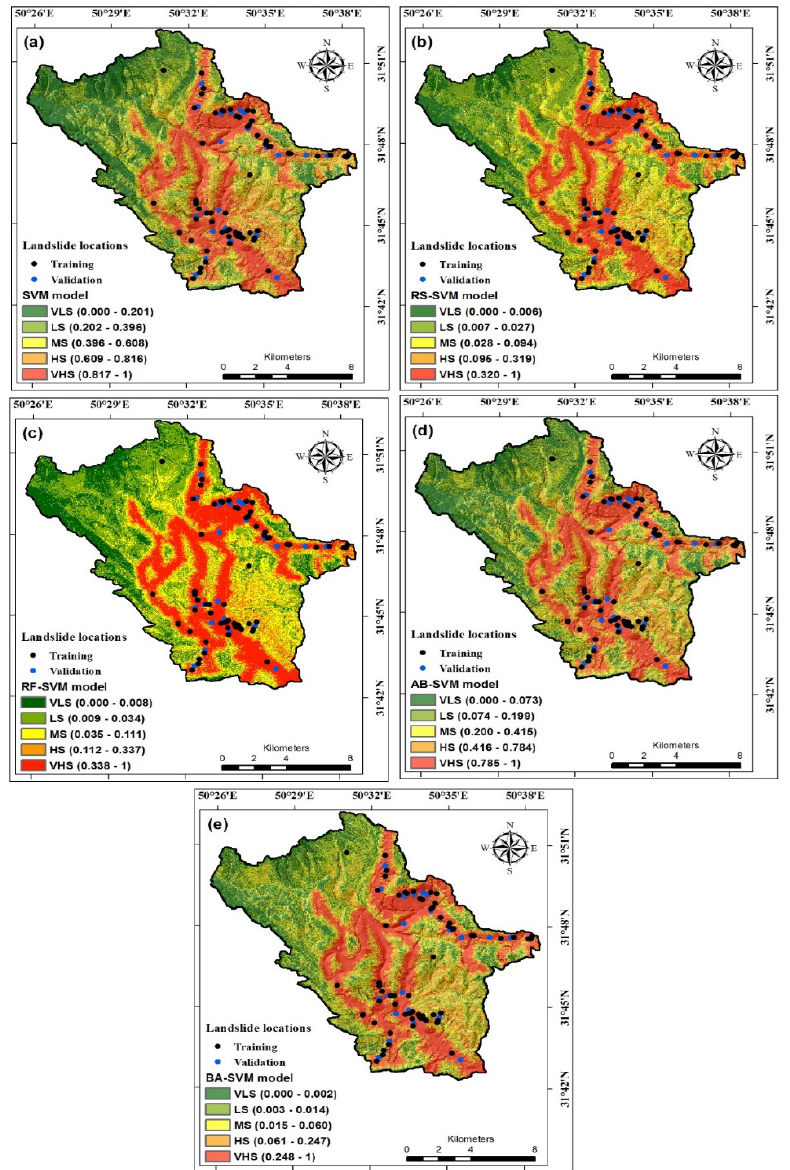
Figure 8. Landslide susceptibility maps derived with SVM and its ensembles: ( a ) SVM; ( b ) RS-SVM; ( c ) RF-SVM; ( d ) AB-SVM; ( e ) BA-SVM.